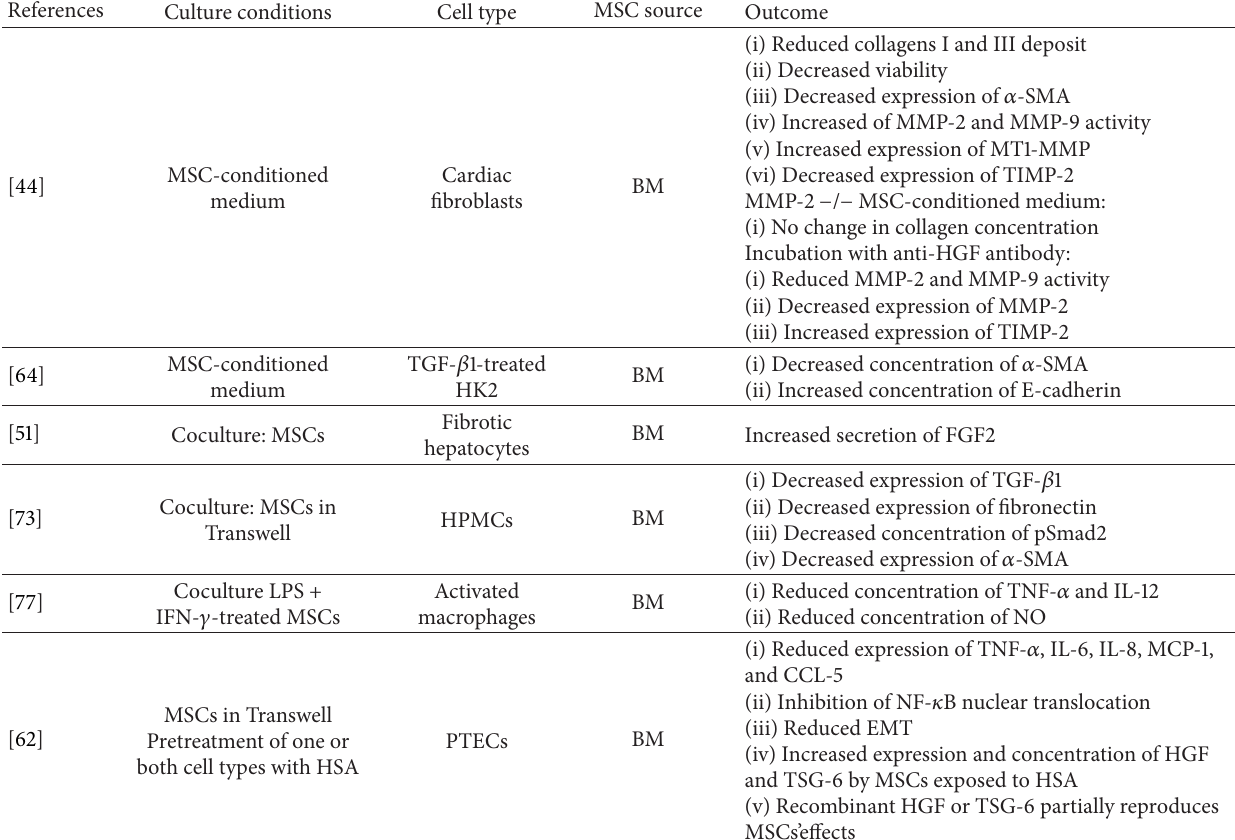
Table 9: Summary of various in vitro studies using MSC-conditioned medium or MSCs cocultured with cells of